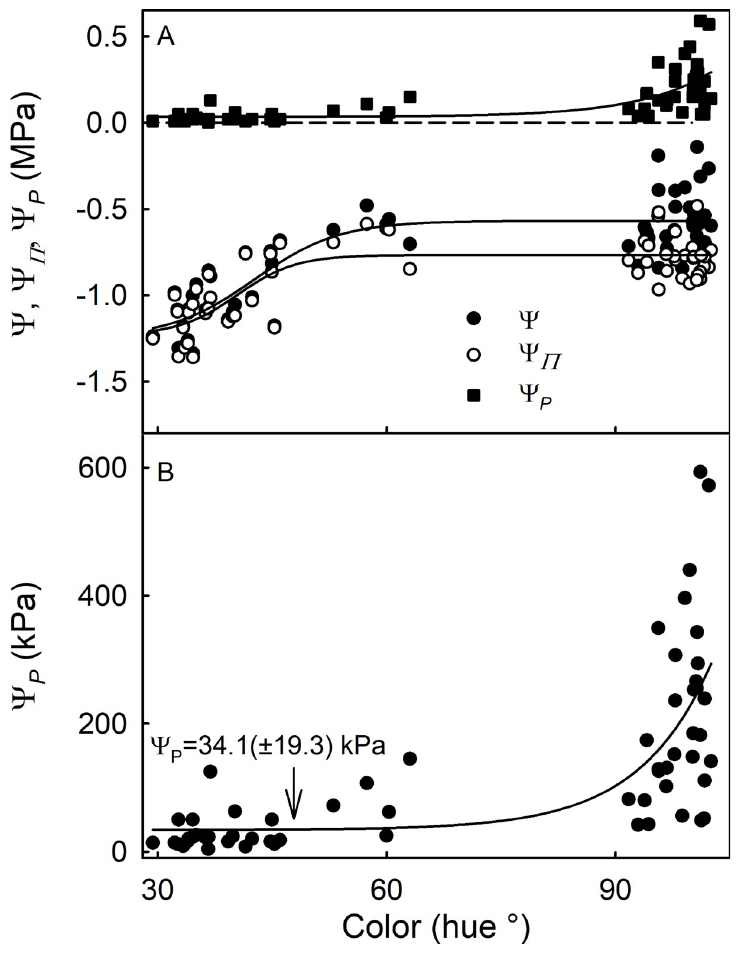
Fig 3. Water potentials in developing strawberries. (A) Calculated fruit water potential ( C ), osmotic potential ( C P ) and cell turgor ( C P ) of developing strawberry fruit; (B) C P in A but redrawn on a different scale. The value of C was calculated as C = C P + C P . (Bars represent SE). The arrow indicates the C P at maturity. The osmotic potential of the expressed fruit juice was nearly constant for unripe fruit rang- ing from green (hue angle > 90˚) to white (hue angle � 60˚), but decreased and became more negative as the fruit turned red (hue angle < 60˚) (Fig 3A). Fruit turgor ( C ) was very low P throughout most of the fruit-development period, compared to the negative values of fruit osmotic potential. Only during the early stages of development, when the fruit were still green, was cell turgor pressure significantly higher, when average values were about 200 kPa, with occasional peak values of up to 600 kPa being recorded (Fig 3B). There was no relationship between the rate of transpiration or the rate of uptake and the osmotic potential of expressed juice for fruit on commercial ripeness (Fig 4A and 4B). Skin permeances for transpiration (P ) and for osmotic uptake (P ) follow a log normal dis- t f log scale and by linear normal probability plots (Fig 5A–5C). The permeance for osmotic uptake was 226-times larger than that for transpiration (Table 2). This huge dissimilarity is not unique to ‘Clery’ strawberry, but was of similar magnitude in ‘Florentina’ and ‘Laetitia’ (Table 1).